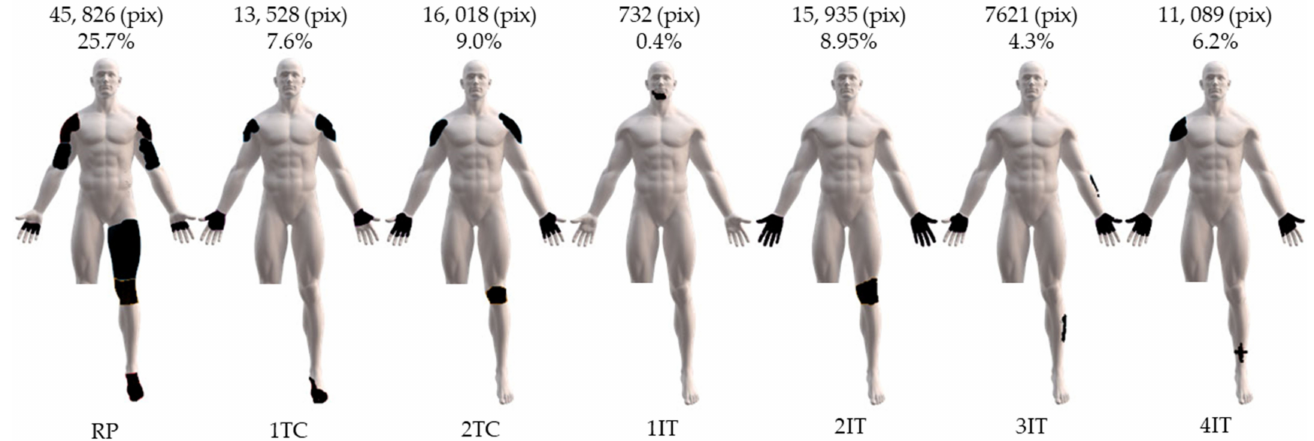
Figure 6. Digital pain drawings of the front body area of the representative player in different time moments (the same as shown in the GNSS data summary table). RP-recall pain, 1–2TC—following days of training camp, 1–4IT—following days of international tournament. Numbers represent the area of pain in pixels and the percentage of the whole front body area, individualized for the representative player.